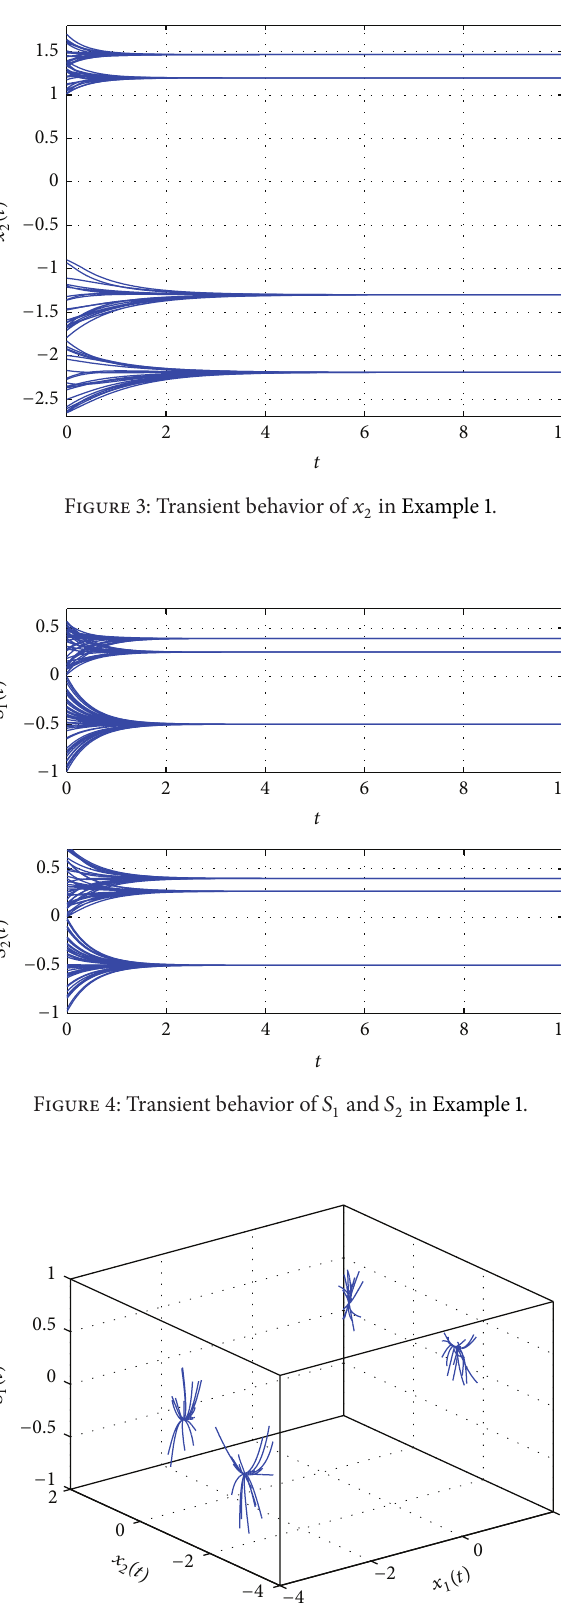
Figure8:Transientbehaviorof 𝑥 1 and 𝑥 2 neartheequilibriumpoint (5/12, −241/120, 5/24, −1/2) 𝑇 in Example